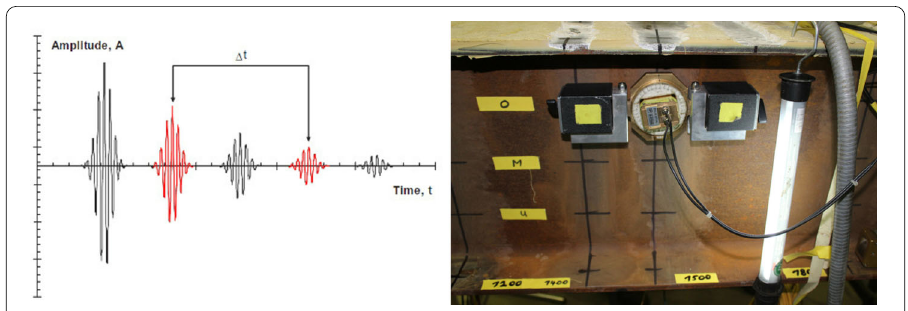
Figure 7 Left: One source of errors is missing one of the echos (compare Abb. 3.7 in [9]). Right: Precise preparation is necessary for feasible measurements